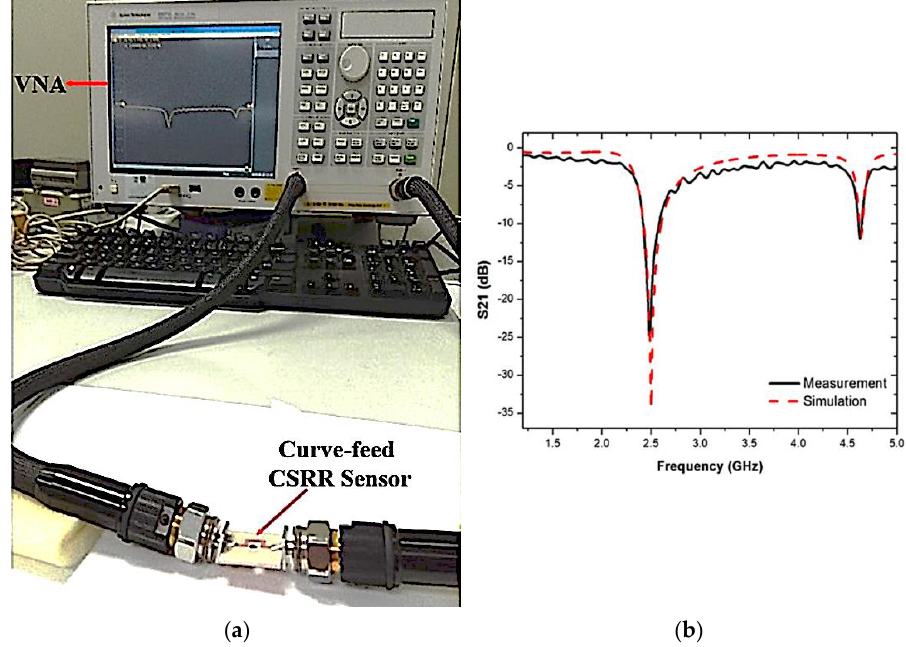
Figure 13. ( a ) Experimental setup, and ( b ) simulated and measured results of curve-feed CSRR sen-